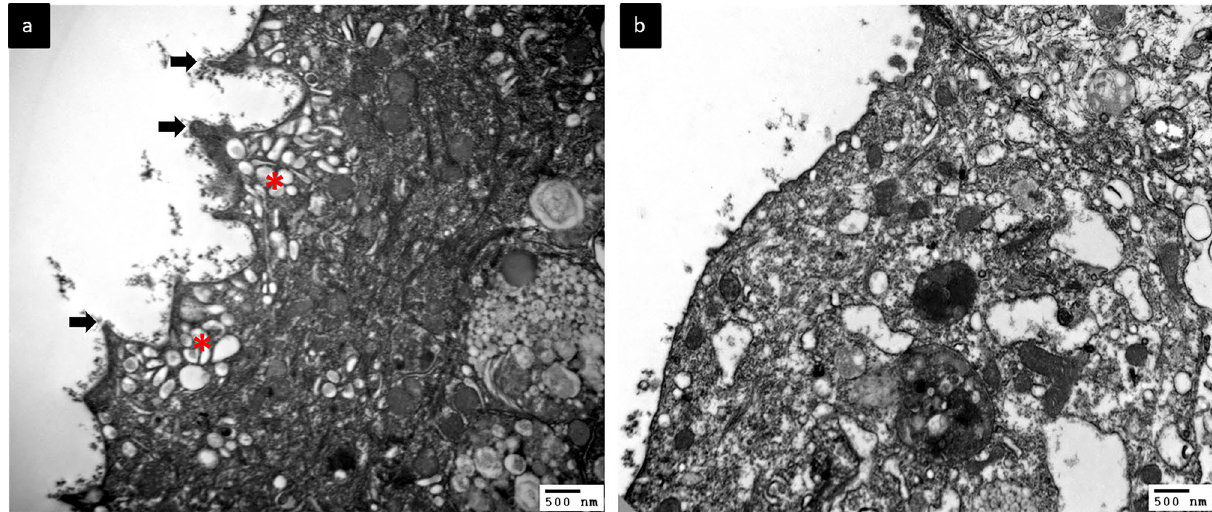
Figure 2. Changes in urothelial surface microstructure in IC/BPS. ( a ) A normal umbrella cell surface covered with numerous uroplakin plaques (arrows) and vesicles (asterisks). ( b ) Patient sample showing a smooth umbrella cell surface without uroplakin plaques and